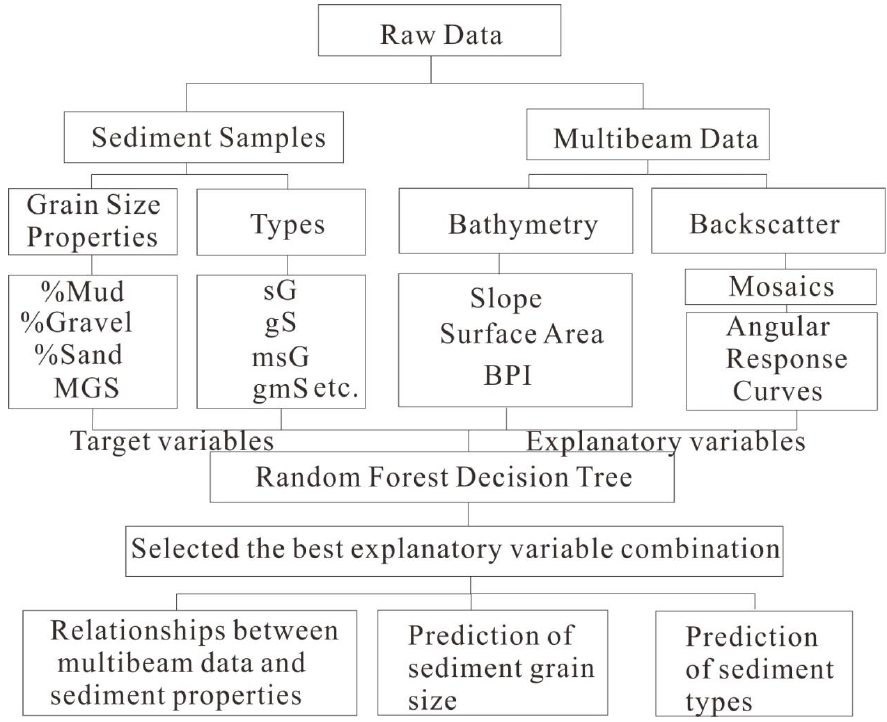
Figure 1. Workflow diagram of the research methods from raw data processing to model prediction.